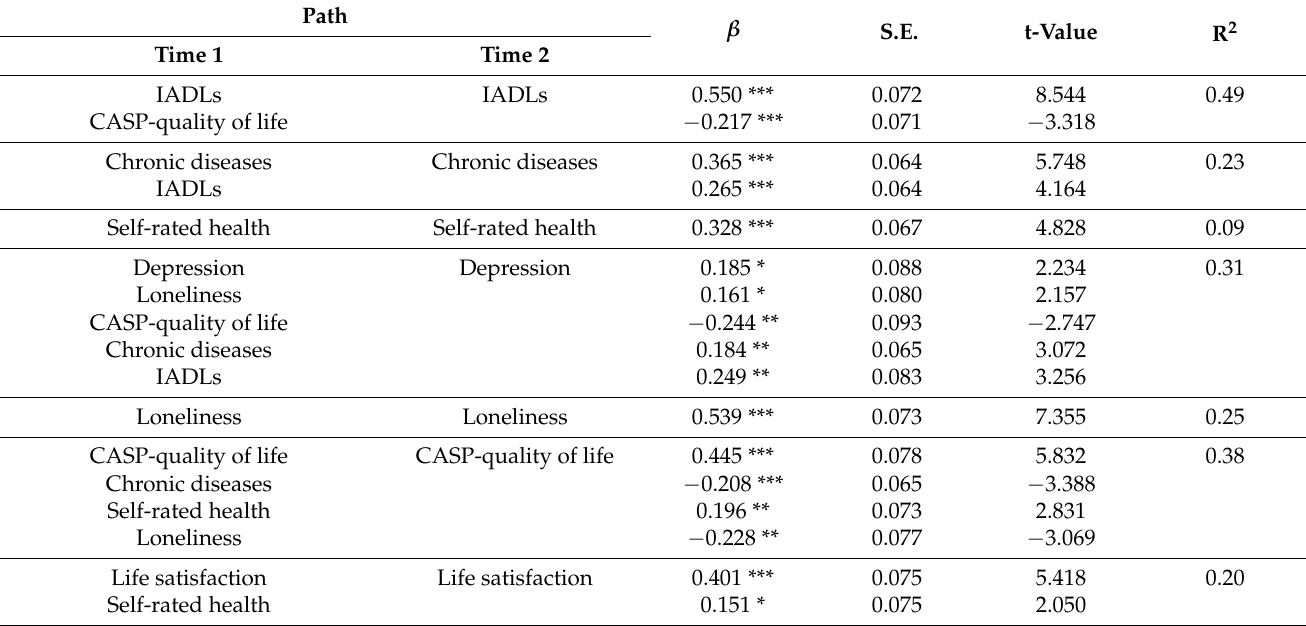
Table 2. Auto-regressive effects and cross-lagged associations in the final reciprocal